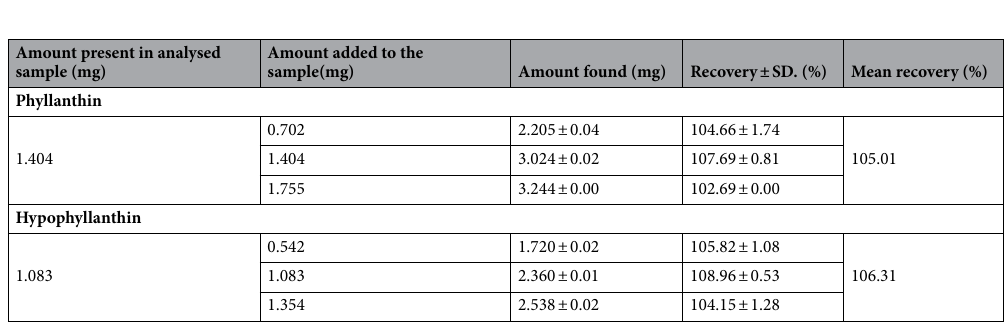
Amount added to the